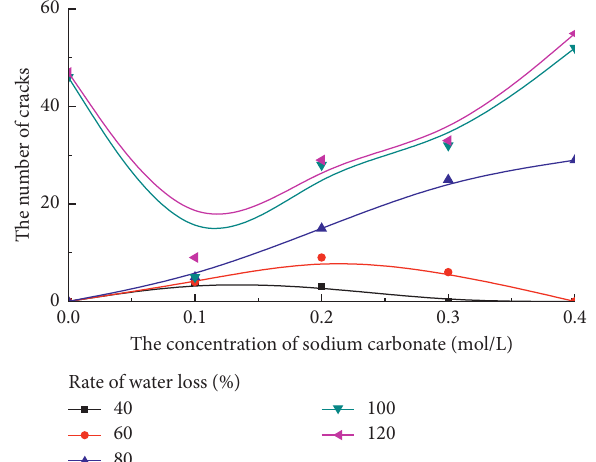
Figure 11: Relationship between the sodium carbonate concen- tration and the number of crack